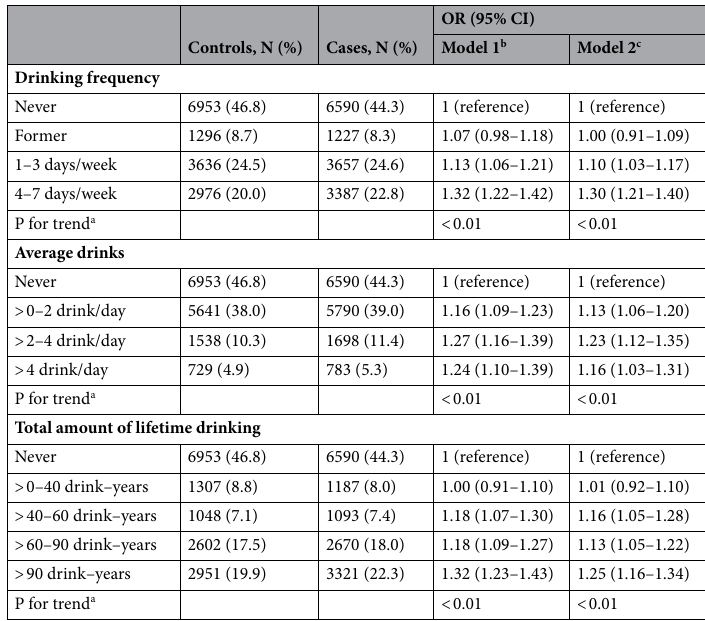
Table 2. Odds ratios for incident cataract surgery estimated with the categorical alcohol use patterns (both men and women). OR odds ratio, CI confidence interval. a Trend test was calculated for the associations between alcohol use patterns as a continuous variable and incident cataract surgery. b Conditional logistic regression matched for sex, age, admission date, and hospital. c Additionally adjusted for smoking history, lifestyle-related comorbidities (hypertension, hyperlipidaemia, diabetes, and obesity), occupational radiation exposure, and outdoor